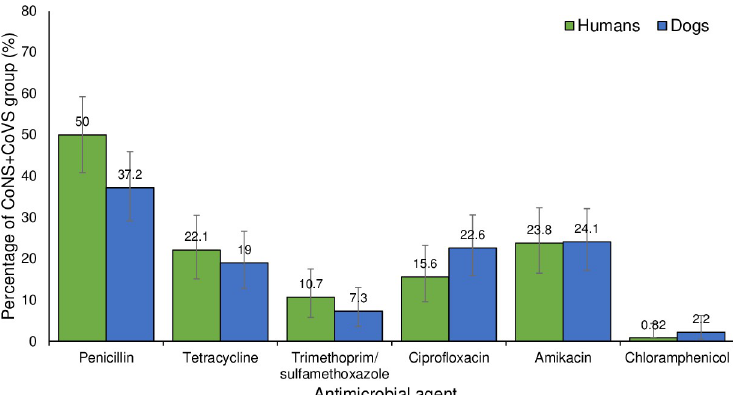
Fig 3. Frequency of detection of antimicrobial resistance in the CoNS+CoVS group isolated from humans (n = 122) and canine pets (n = 137).